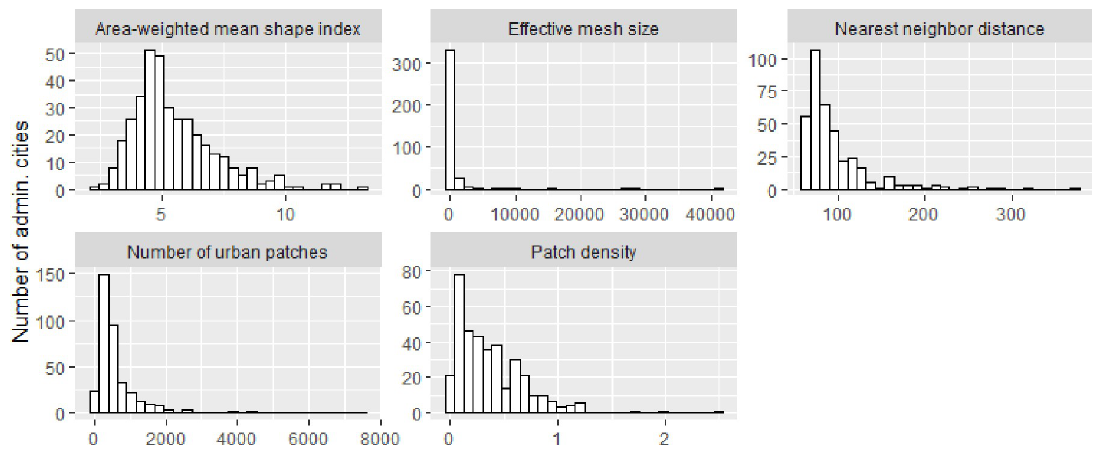
Fig 1. Histograms of the distribution of urban landscape